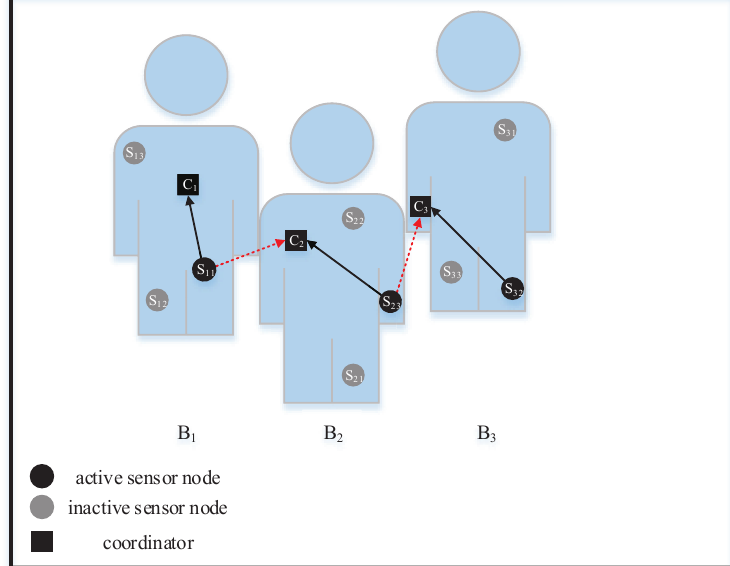
Figure 1. Interference model among co-located